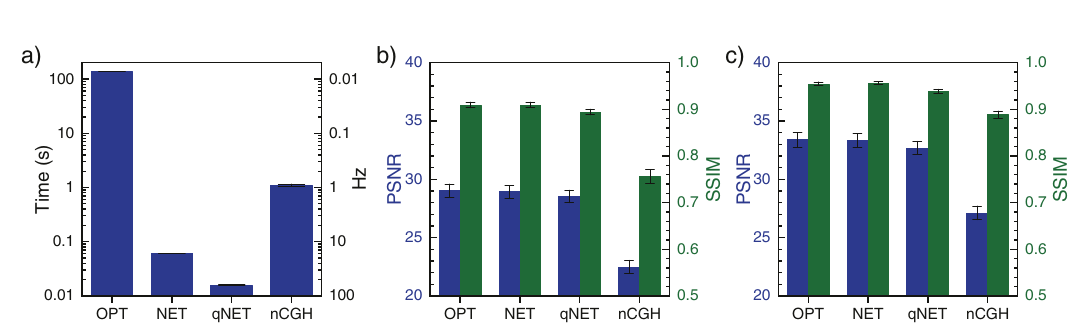
NET, and qNET have similarPSNRvalues(29.0,28.9, and 28.5dB,respectively)and SSIM values (0.909, 0.910,and 0.894,respectively),while nCGH givessigni fi cantly lowerPSNR(22.5dB)andSSIM(0.756)values. c ThePSNRandSSIMwereevaluated for the FHD resolution dataset. For the OPT, NET, qNET, and nCGH methods, the SSIM (PSNR) valuesweregiven by 0.955 (33.4dB),0.957(33.4dB), 0.939(32.7dB), and 0.889 (27.1dB), respectively. The error bars represent the standard deviations between